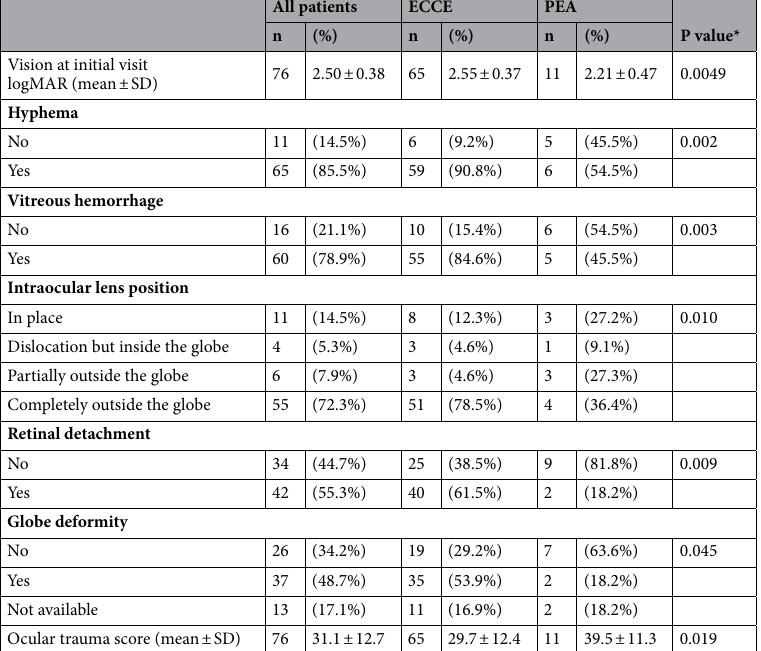
All patients ECCE